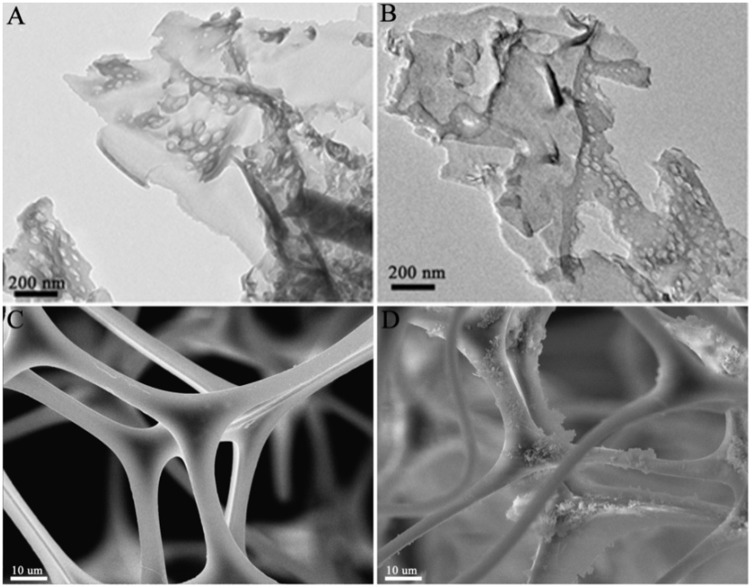
TEM images of samples: (A) g-C3N4; (B) sonicated g-C3N4. SEM images of samples: (C) MS; (D) g-C3N4/MS.